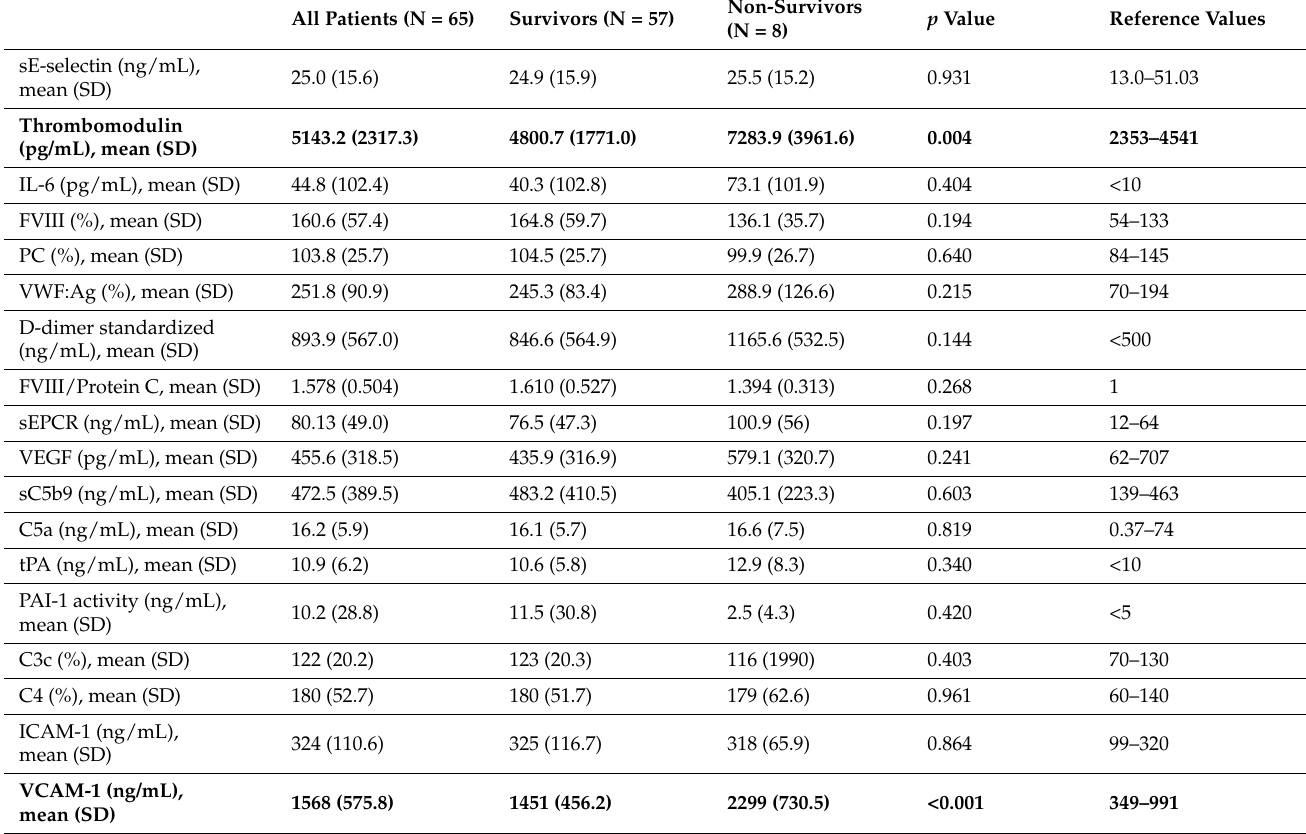
Table 5. Humoral biomarker levels in survivors vs.